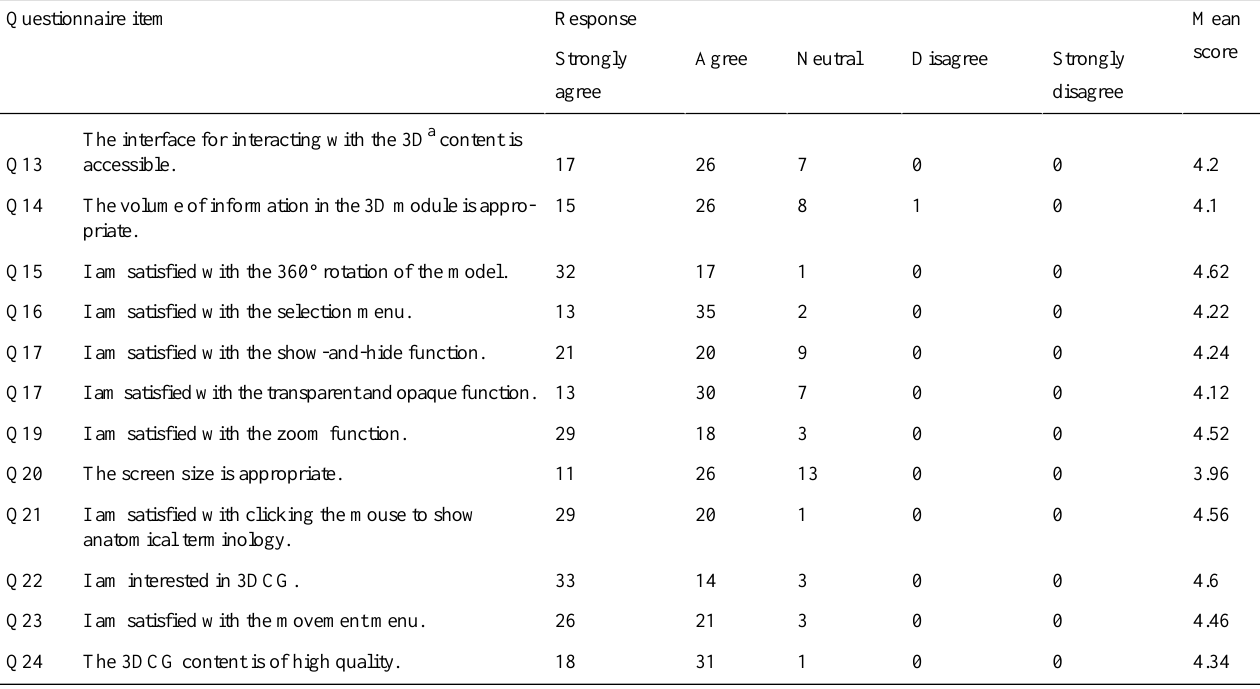
Table 3. Questionnaire scores for the 3-dimensional computer graphics (3DCG) model interface (n =